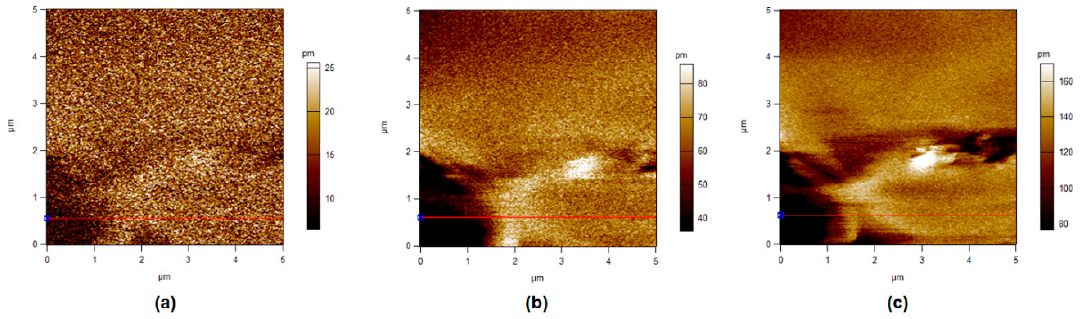
Figure 10. PFM Amplitude retrace of PVDF/TPU (1:1) at different applied voltages. ( a ) 1 V, ( b ) 5 V, and ( c ) 10 V.